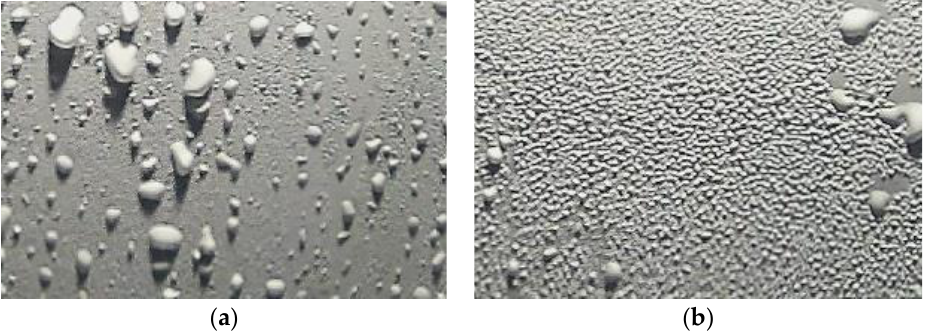
Figure 6. Example nighttime images of the reference surface using artificial illumination: ( a ) with large water droplets formed due to rain and ( b ) with tiny water droplets formed due to dew.